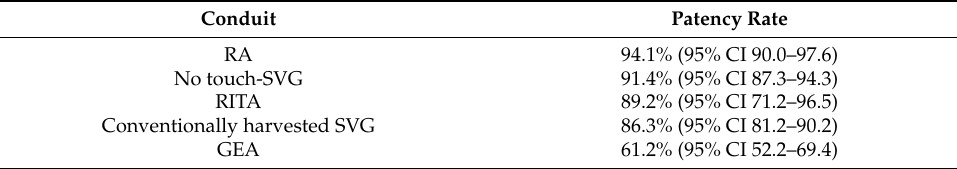
Table 1. Angiographic outcomes of currently used coronary artery bypass